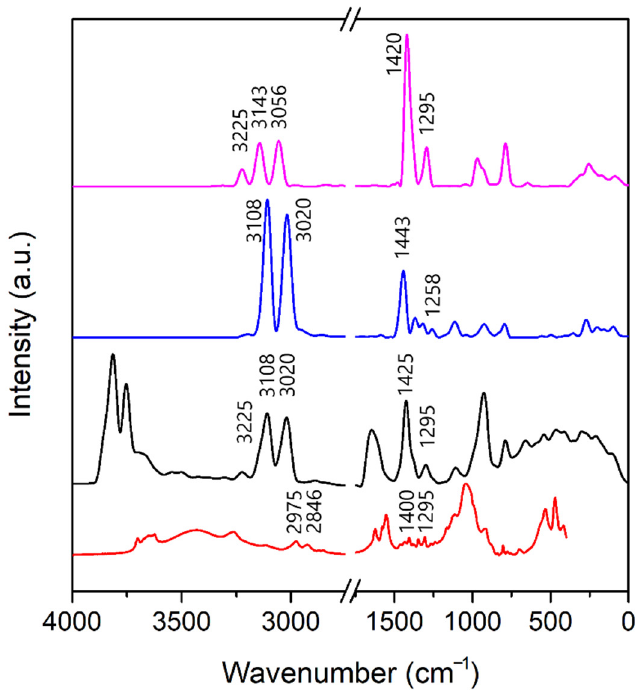
Figure 9. The contribution of the calculated projected VDOS of the C–H vibrations for atrazine (blue) and the TMP cation (magenta), the calculated total VDOS (black) and the experimental FTIR spectrum (red) for the A-TMP-Bd model.